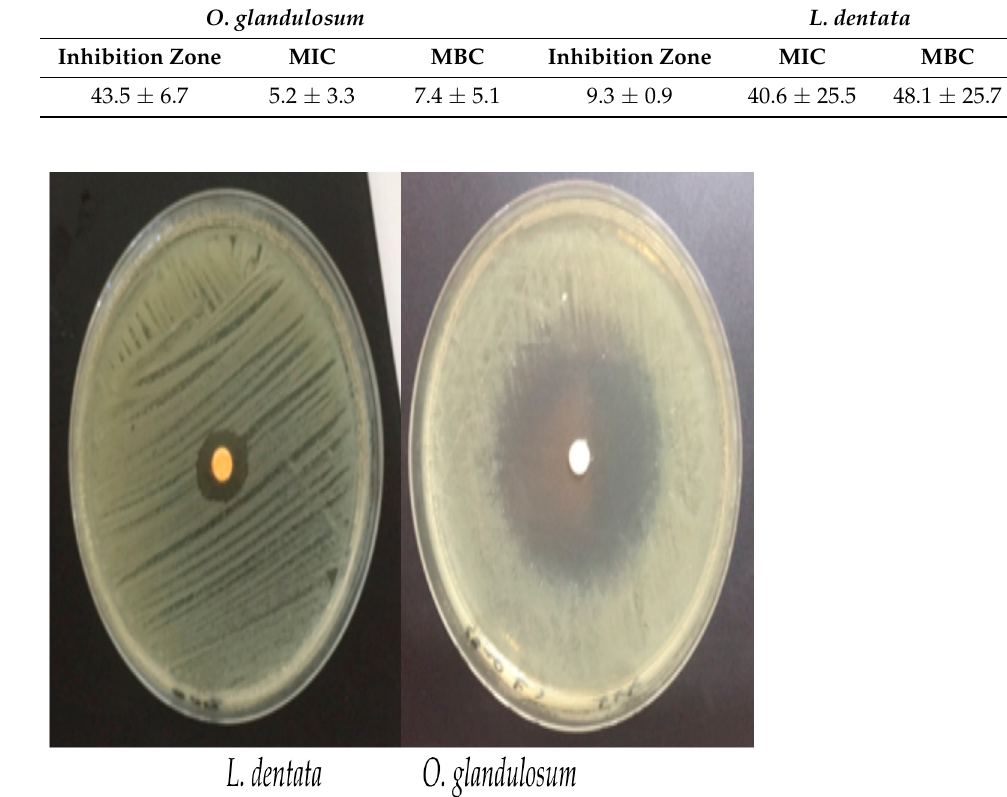
presses as mg/mL, obtained with O. glandulosum and L. dentata essential oils tested against ESBL K. pneumoniae strains.